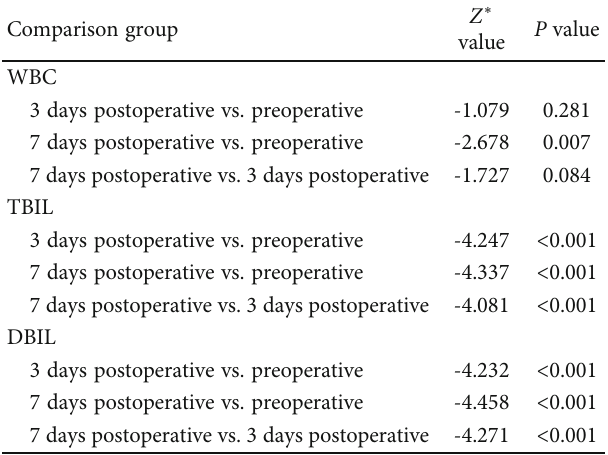
Table 3: The pair-wise comparison of WBC, TBIL, and